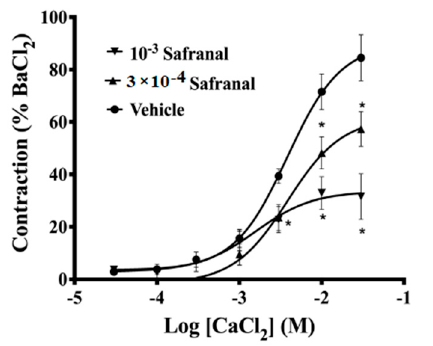
Figure 4. Concentration–response curves of CaCl 2 (3 × 10 − 5 –3 × 10 − 2 M) in the presence of 3 × 10 − 4 M safranal (triangles, n = 11) and 10 − 3 M safranal (inverted triangles, n = 11) or the vehicle (circles, n = 9). Contractile responses are expressed as a percentage of maximum contraction evoked by BaCl 2 (3 × 10 − 3 M). Values are means ± SEM. * indicates that p < 0.05 compared to the vehicle.